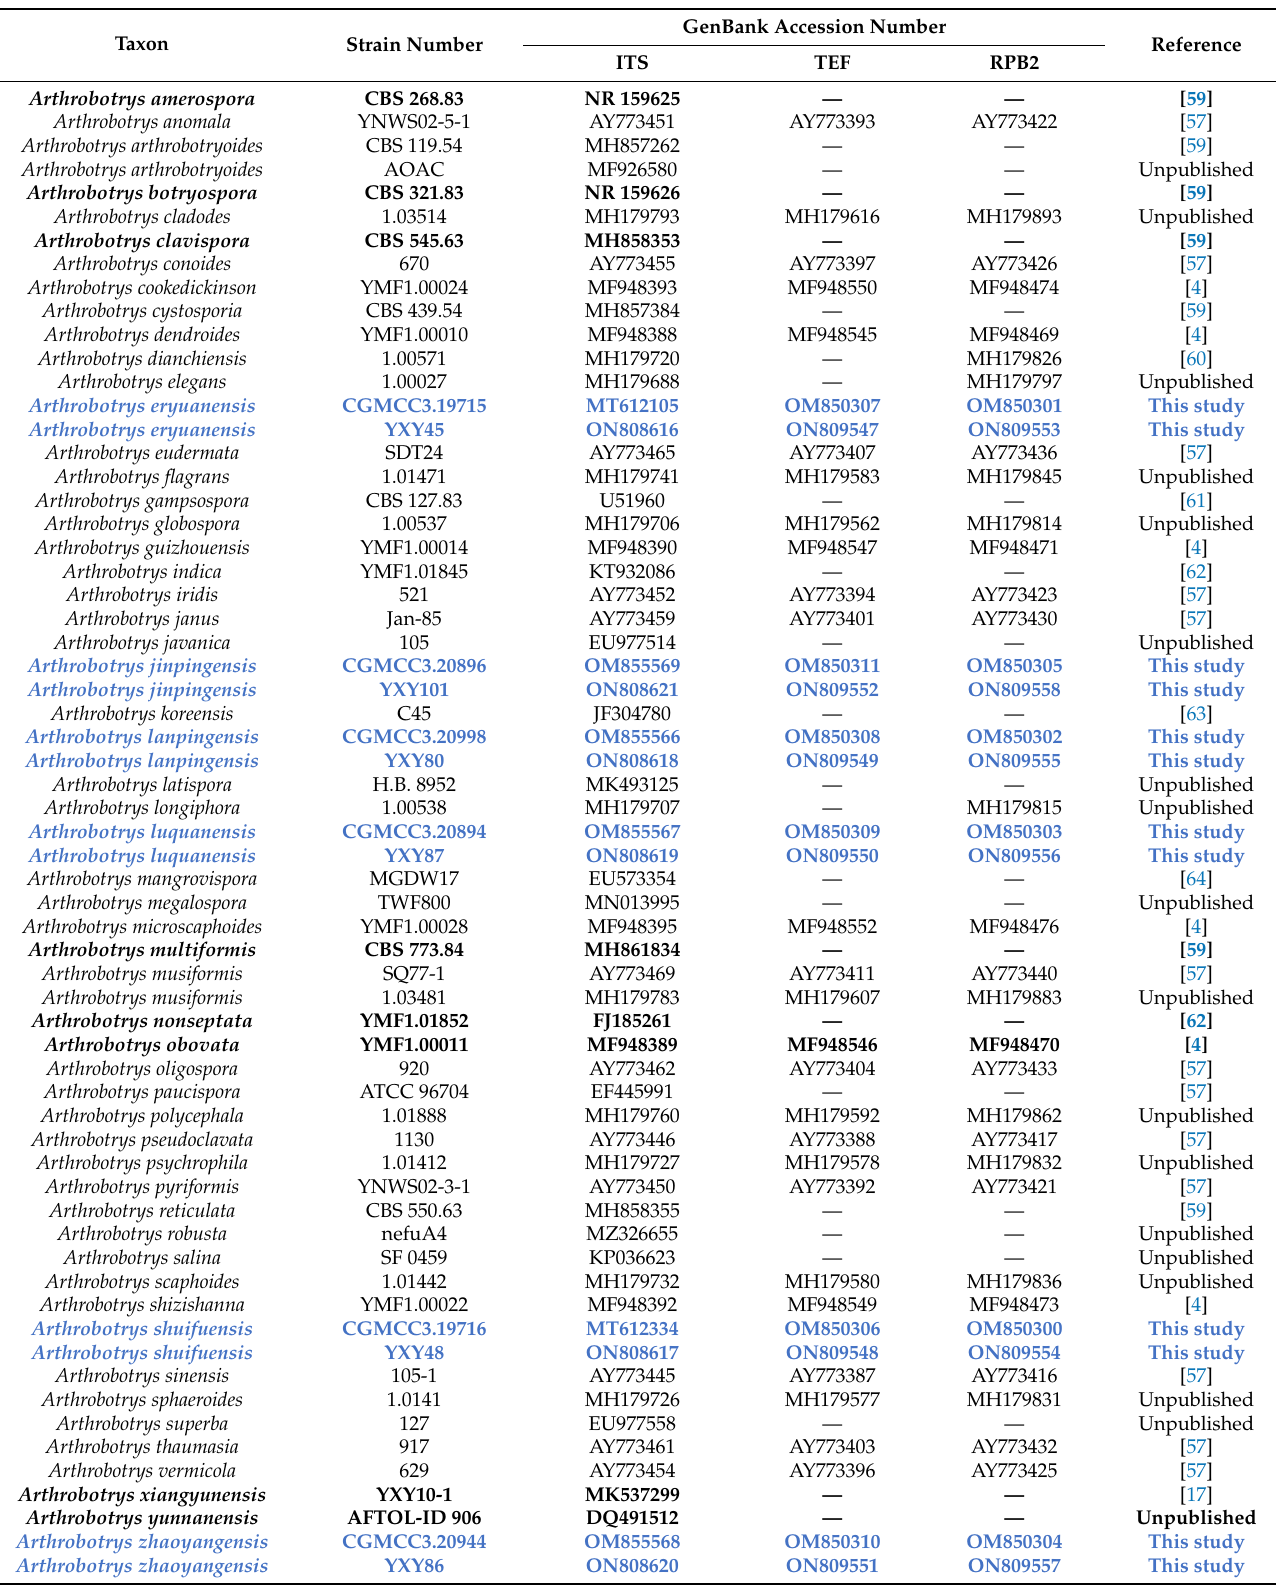
Table 1. The GenBank accession numbers of the isolates included in this study. Ex-type strains are in bold. The newly generated sequences are indicated in